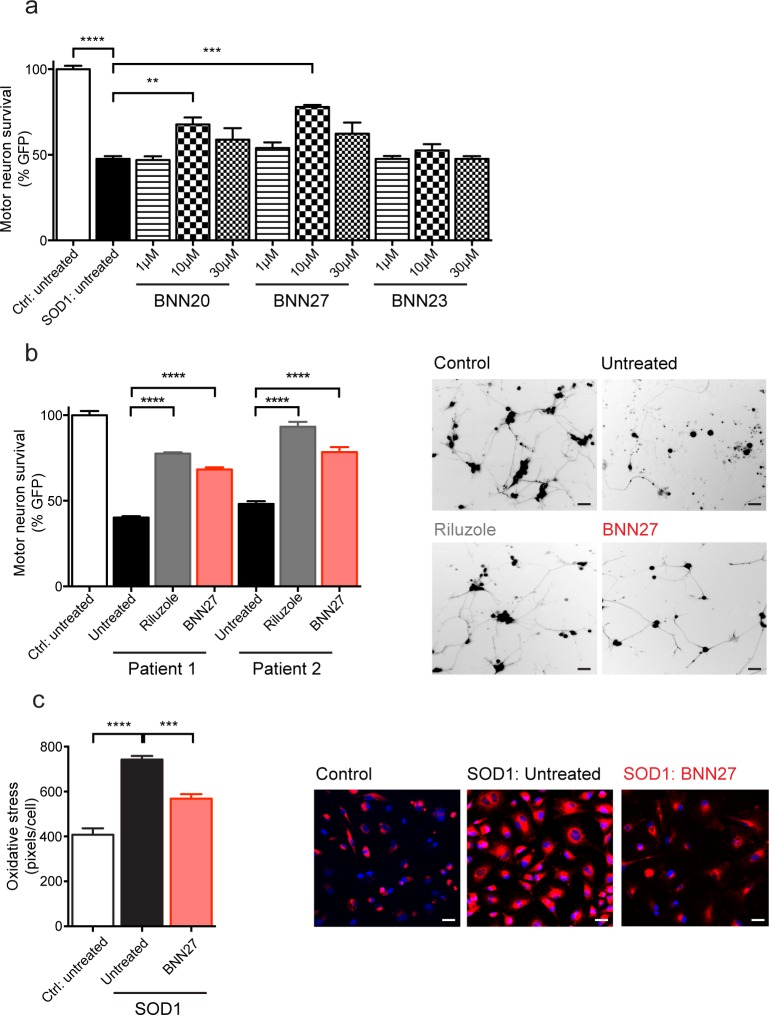
MNTs attenuated survival of mouse motor neurons co-cultured with human astrocytes from SOD1 ALS patients.a) Survival of mouse motor neurons (MNs), expressing GFP under the Hb9 promoter, was significantly decreased in co-cultures with human astrocytes (iAstrocytes) from an ALS patient a SOD1 mutation (Patient 2/SOD1 210; light grey) compared to those from 3 compiled control patients (3 compiled; white) (p<0.0001, unpaired t-test). BNN20, BNN27, and BNN23 were each tested at 1 μM (dark grey), 10 μM (black), and 30 μM (medium grey) in iAstrocyte-mouse MN co-cultures. At 10 μM, BNN20 (p<0.01, Tukey’s test) and BNN27 (p<0.001, Tukey’s test) significantly increased the survival of MNs co-cultured with SOD1 iAstrocytes relative to untreated samples. b) The effects of BNN27 (red) were tested, along with Riluzole (dark grey), on iAstrocytes from 3 control patients (compiled) and 2 individual ALS patients each carrying a distinct SOD1 mutation (Patient 1/SOD1 91 and Patient 2/SOD1 210). Left, BNN27 (10 μM) treatment yielded a significant increase in MN survival in co-cultures with iAstrocytes from Patient 1 (p<0.0001, Tukey’s test) and Patient 2 (p<0.0001, Tukey’s test) relative to untreated co-cultures (light grey). Similarly, Riluzole (10 μM) treatment also significantly increased MN survival in co-cultures with Patient 1 (p<0.0001, Tukey’s test) and Patient 2 (p<0.0001, Tukey’s test) iAstroctyes. Right, representative images of mouse MNs co-cultured with iAstrocytes from control untreated (control), SOD1 210 untreated (untreated), SOD1 210 Riluzole (Riluzole), and SOD1 210 BNN27 (BNN27). Scale bar = 20μM. c) Oxidative stress levels were significantly increased in iAstrocytes from 2 ALS patients containing a SOD1 mutation (Patient 1/SOD1 91 and Patient 2/SOD1 210; light grey) compared to those from 2 control patients (white) (p<0.0001, Tukey’s test). BNN27 treatment (red) produced a significant decrease in oxidative stress levels from SOD1 iAstrocytes relative to untreated cells (p<0.001, Tukey’s test). Scale bar = 10μM. Experiments were performed in triplicate (a, c) and quadruplicate (b). Data are presented as mean ± SEMs. ** p<0.01, ***p<0.001, ****p<0.0001.